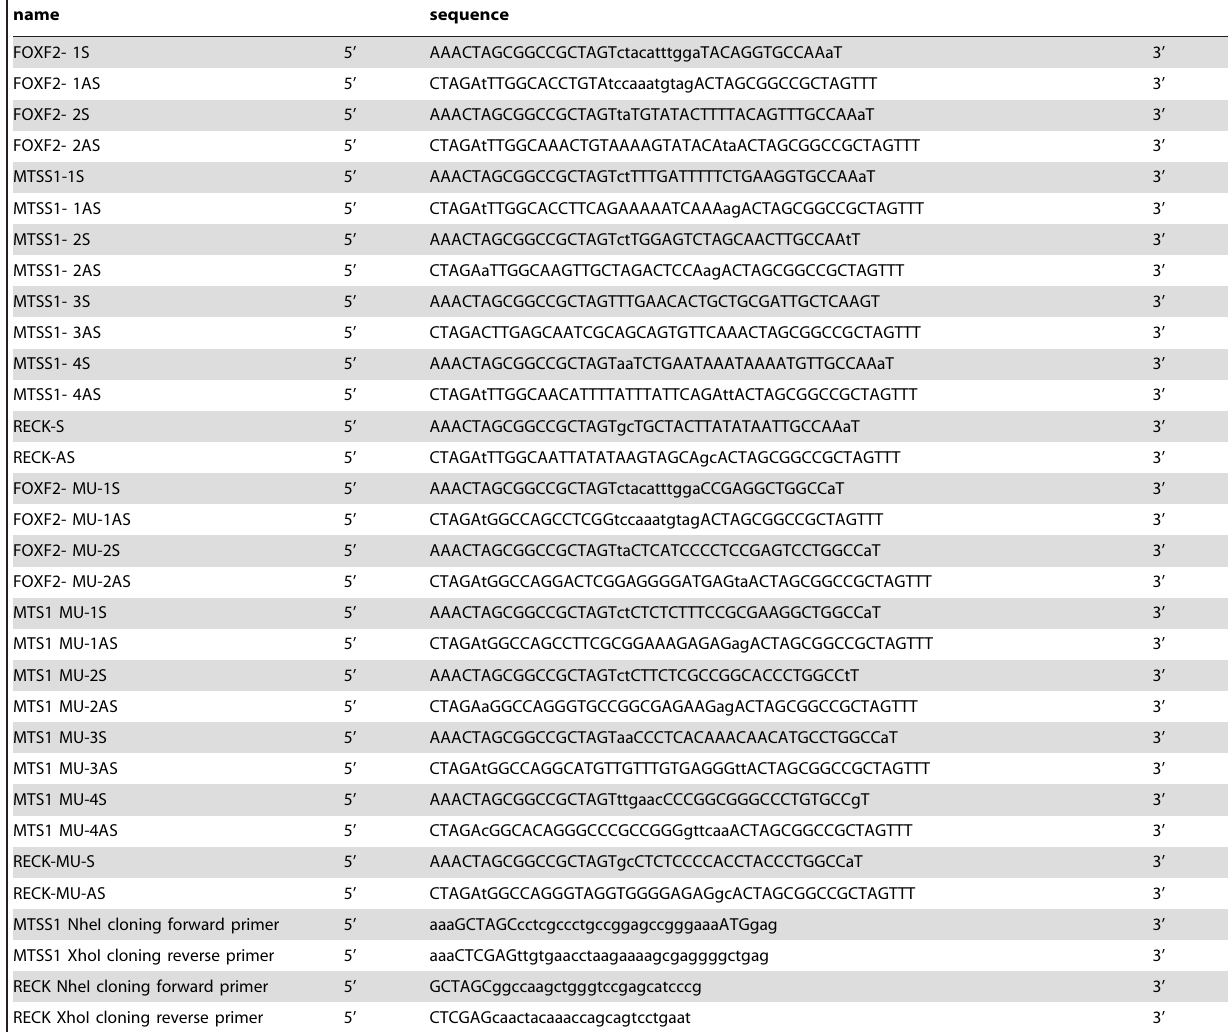
Table 2. Primer sequences used for plasmid